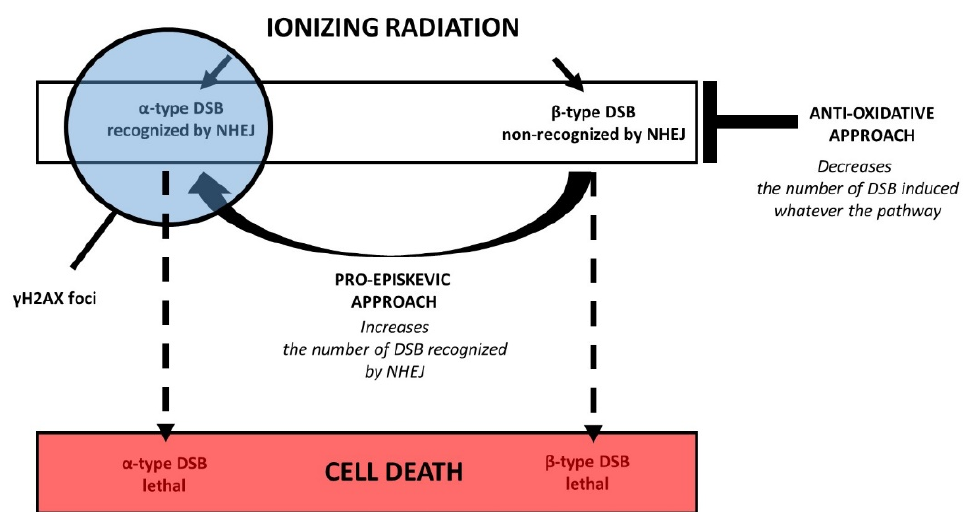
Figure 8. Schematic view of the molecular and cellular consequences of an exposure to IR inducing two types of DSB. The α -type DSB are recognized by the NHEJ DSB repair pathway, while the β -type DSB are not [38]. For each type of DSB, there are some subsets of unrepaired DSB [38]. Among them, some may be unrepairable and participate in the lethal effect. The γ H2AX foci reveal the α -type DSB only. The antioxidative approach consists in reducing the number of DSB involved by IR, independently of the DSB repair pathways involved in their recognition. The pro-episkevic approach consists in increasing the number of DSB recognized by NHEJ by accelerating and facilitating the RIANS and therefore by stimulating the efficiency of NHEJ.